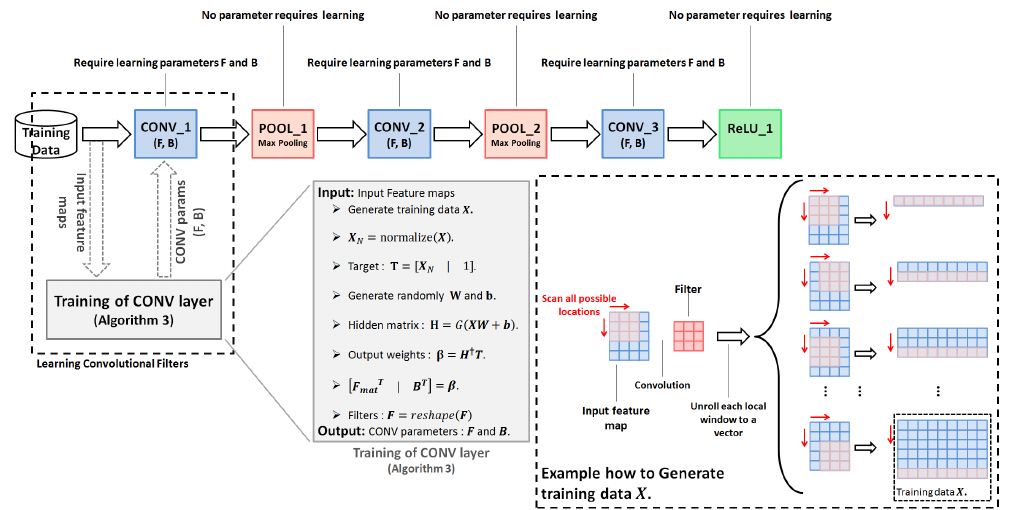
Figure 3. The overall structure of the ELM-CNN approach. Any basic CNN architecture can be implemented as a stack of blocks with a specified operation (Convolution, Pooling, and ReLU), where only the convolutional layers require training.